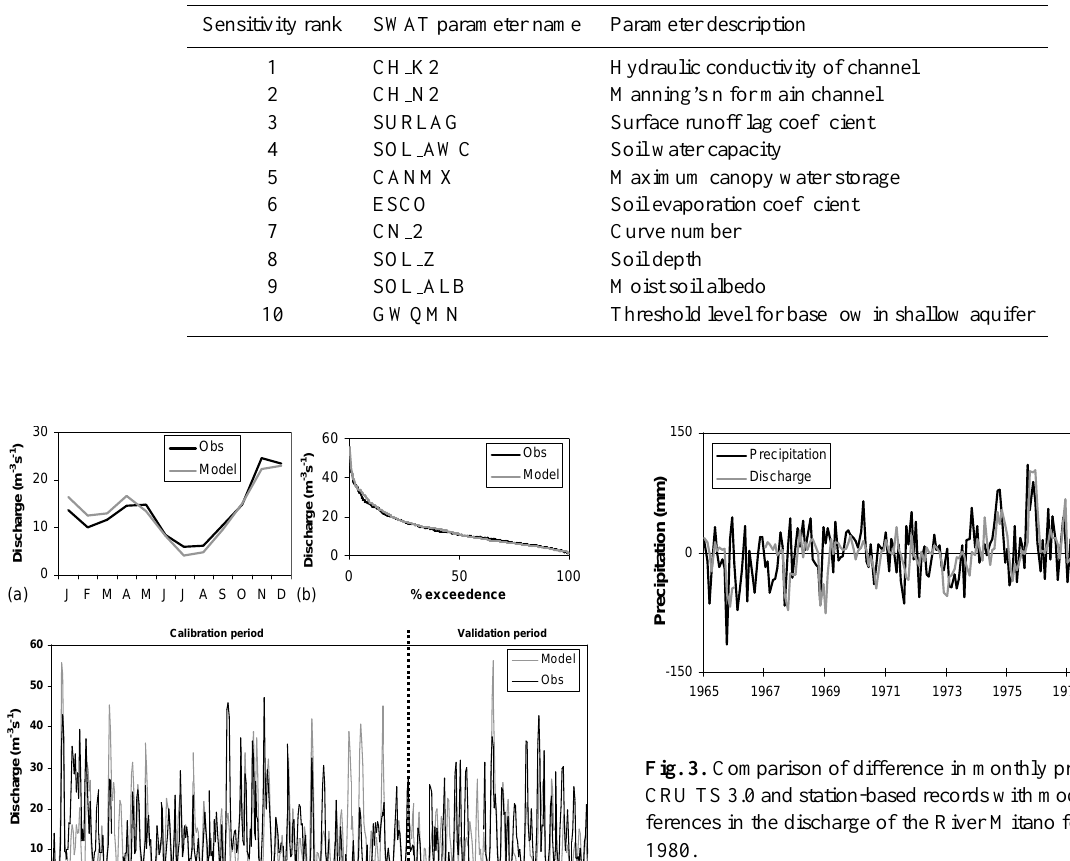
Table 1. The ten most sensitive parameters in the SWAT model of the Mitano River Basin.